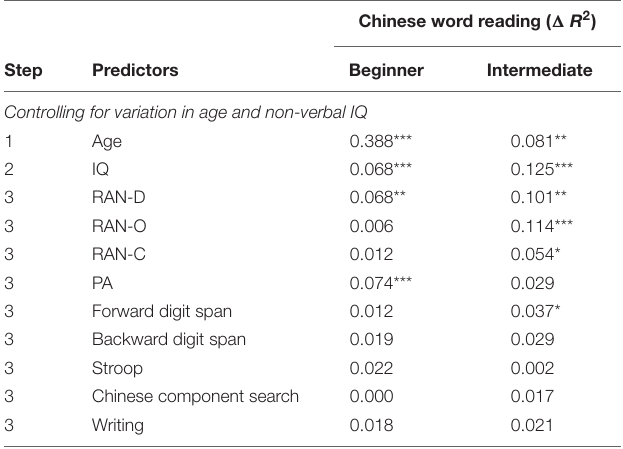
TABLE 4-1 | Summary of hierarchical multiple regressions that tested the predictive power of various component skill measures for Chinese word reading.